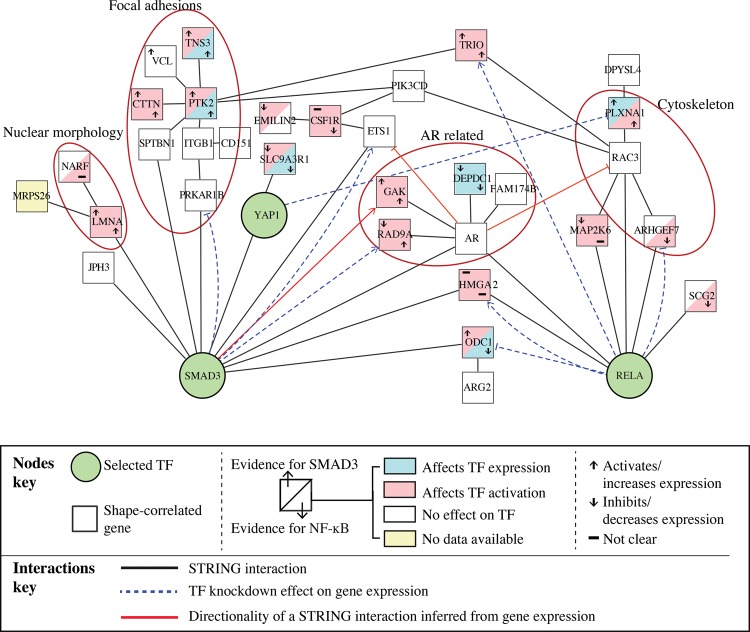
SMAD3-NF-κB subnetwork. Proteins that are in a direct path from a phenotypic feature to RELA, SMAD3, or YAP1 (Supplemental Table S6) and their interactions based on STRING. Edges in dashed lines are based on gene expression and indicate feedback from a TF to proteins encoded by shape-correlated genes.